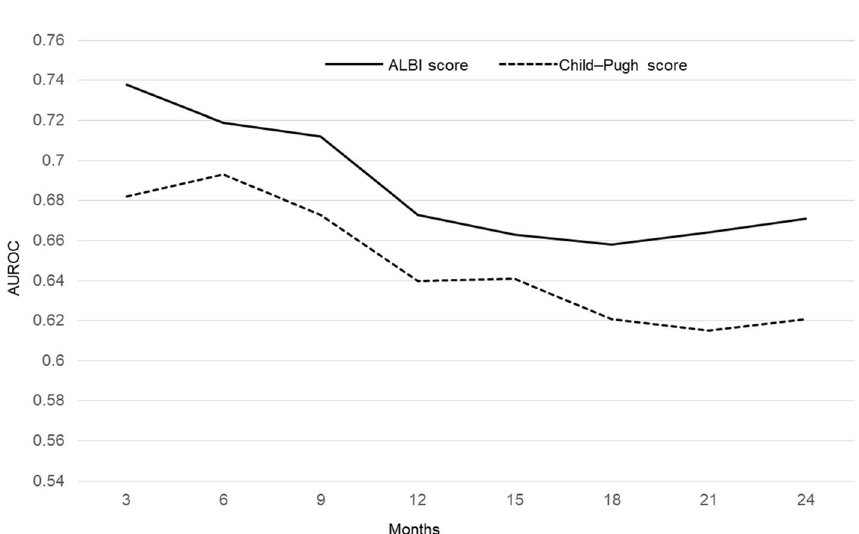
Figure 4. Time-dependent AUROCs of the ALBI and Child–Pugh scores for overall survival after the start of follow-up. Based on time-dependent ROC analysis, the AUROCs of the ALBI and Child–Pugh scores for overall survival at 3, 6, 9, 12, 15, 18, 21, and 24 months were 0.738 and 0.682, 0.719 and 0.693, 0.712 and 0.673, 0.673 and 0.640, 0.663 and 0.641, 0.658 and 0.621, 0.664 and 0.615, and 0.671 and 0.621, respectively. Based on time- dependent AUROCs, the ALBI score had a higher predictive power for overall survival than the Child–Pugh score. AUROC Area under the receiver operating characteristic curve, ALBI